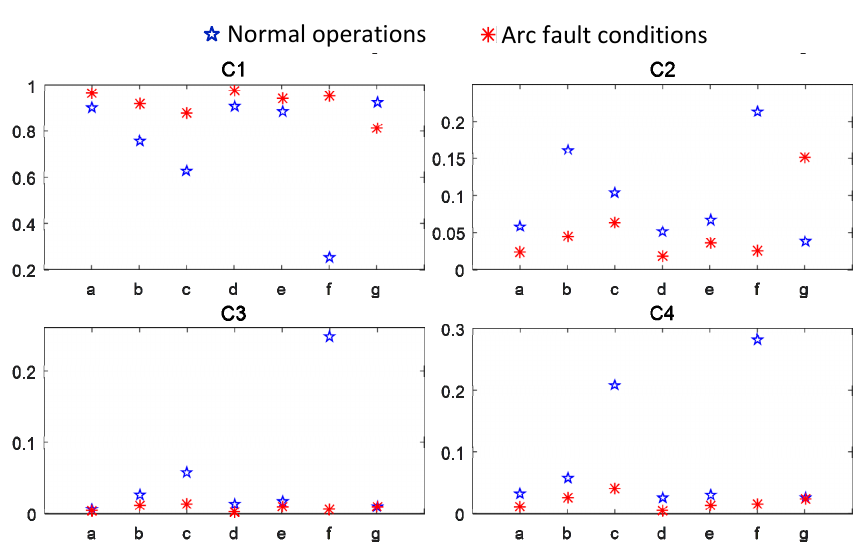
Figure 11. The percent of the energy of Cj in the whole signal energy of different load types during normal operations and serial arc fault conditions (Y axis indicates the percent of the energy of Cj in the whole signal energy). (a) Induction cooker. (b) Incandescent lamp. (c) Hairdryer. (d) Notebook computer. (e) Electric drill. (f) Electric oven. (g) Vacuum cleaner